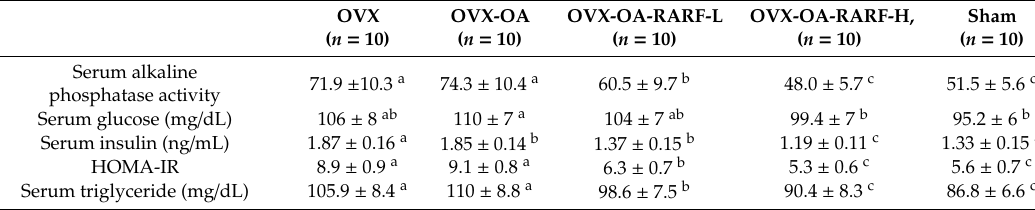
Table 4. Serum glucose, insulin and triglyceride